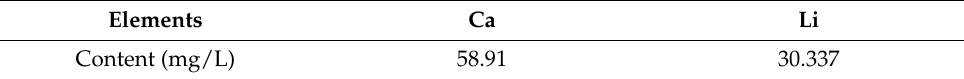
Table 4. Content of solution composition after precipitation of lithium